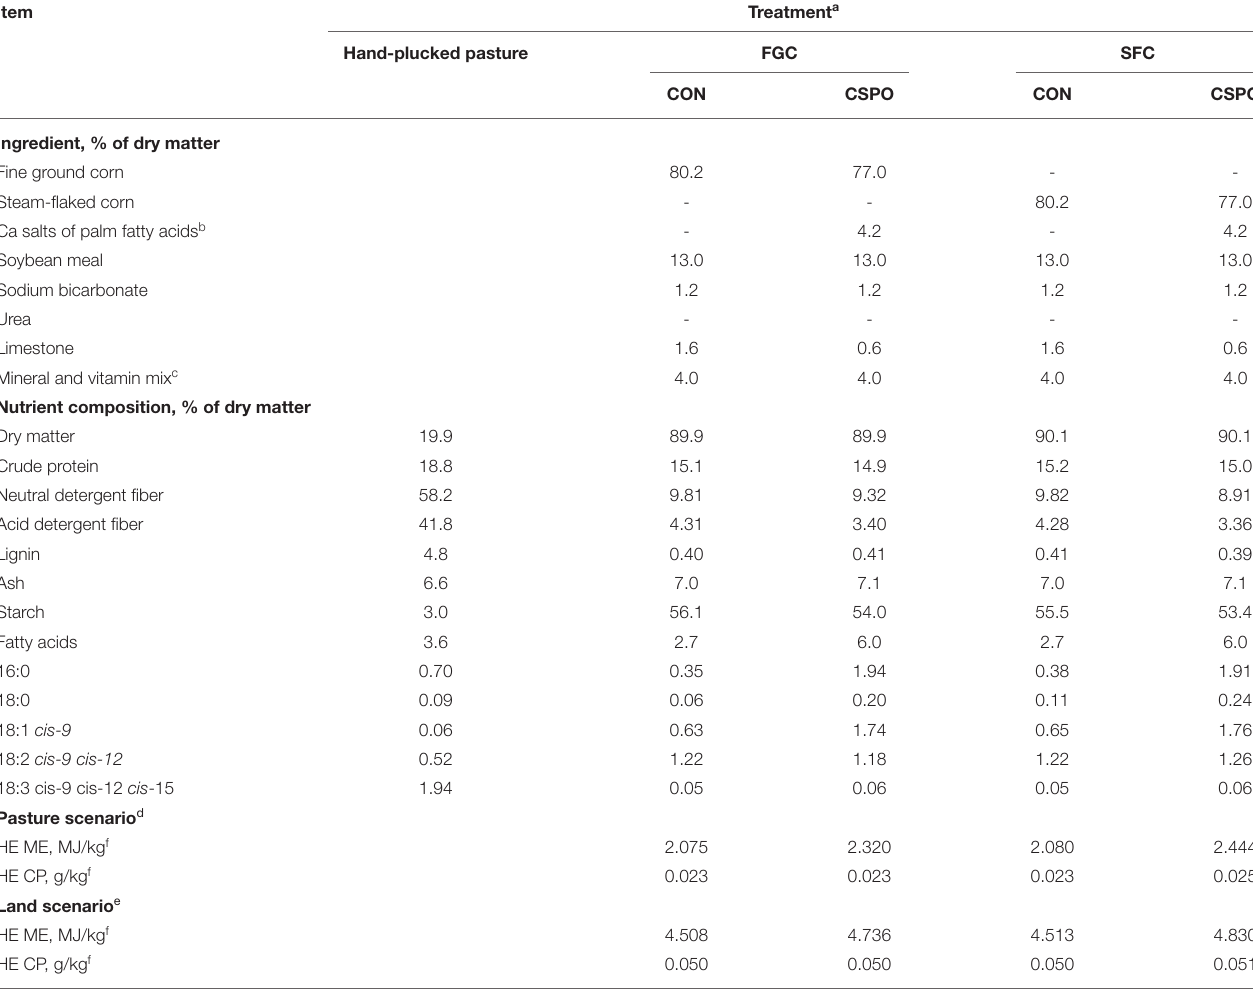
TABLE 1 | Ingredients and nutritional composition of diets provided in both experiments 1 and 2. Item Treatment a Hand-plucked